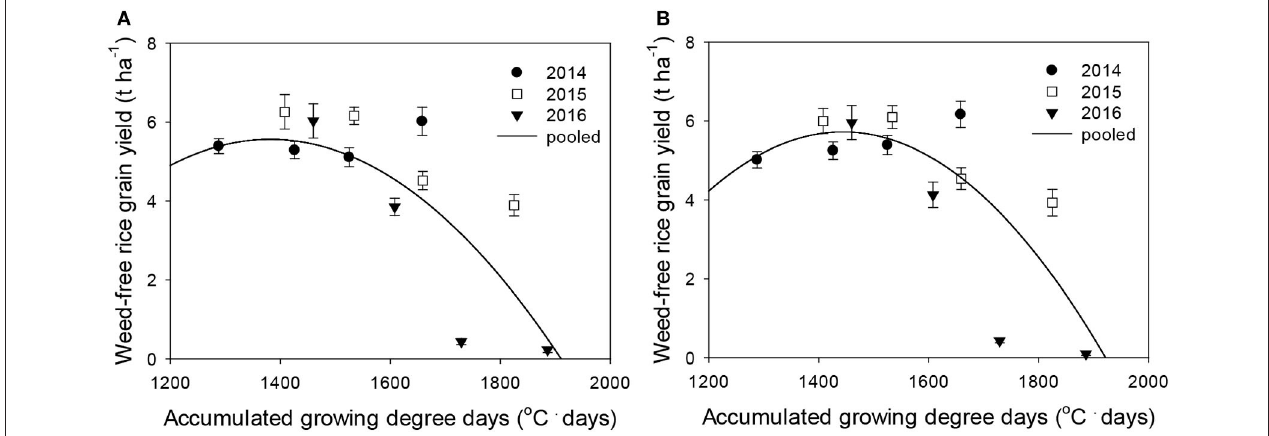
FIGURE 4 | Weed-free rice grain yield ( Y o ) as a function of the accumulated growing degree days (from transplanting to flowering, 89 days) at four sunlit temperature-controlled phytotrons adjusted to ambient, + 1.5 ◦ C, + 3.0 ◦ C, and + 5.0 ◦ C in 2014, 2015, and 2016. The lines are fitted values calculated, using the quadratic model and parameter estimates ( Supplementary Table 2 ) in the pooled 3-year data of late watergrass (A) and water chestnut (B) .